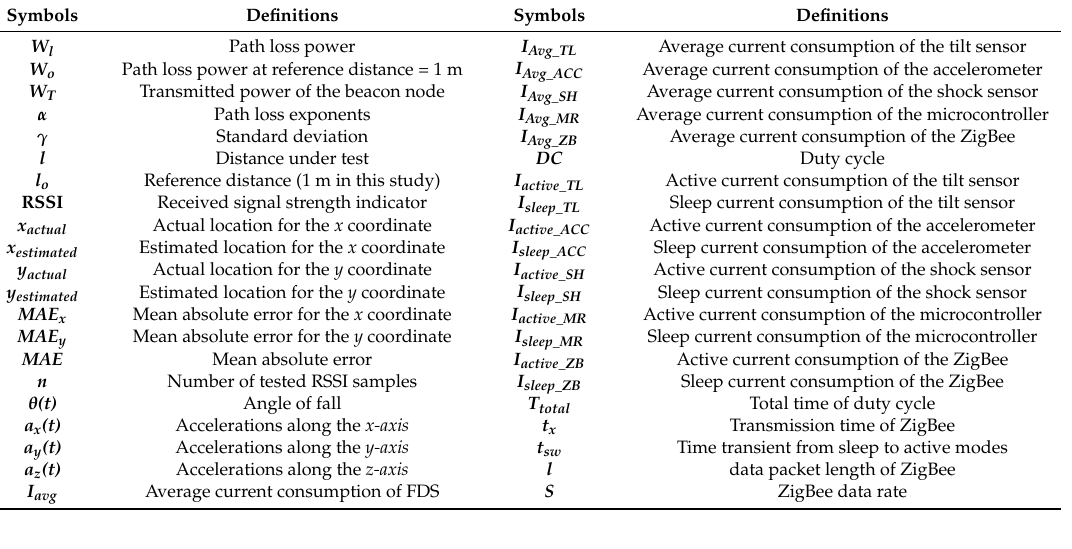
Table 1. Notations and definitions.